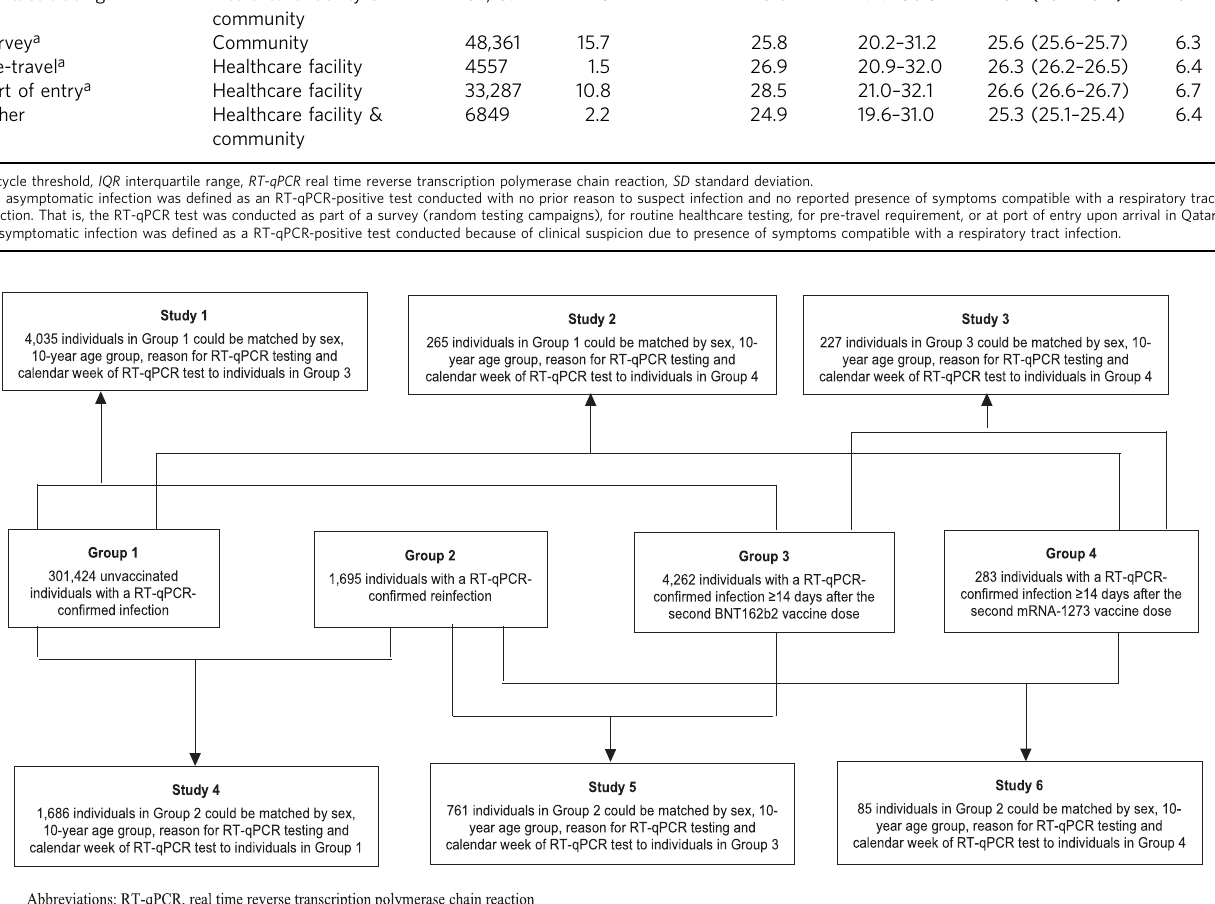
Fig. 2 Schematic diagram showing the process of formulating the six pairwise comparisons between study cohorts. Schematic diagram showing the process of formulating the six pairwise comparisons between the cohorts of primary infections in unvaccinated individuals, reinfections in unvaccinated individuals, BNT162b2-vaccine breakthrough infections, and mRNA-1273-vaccine breakthrough infections, after 1:1 matching by sex, 10-year age group, reason for RT-qPCR testing, and calendar week of the RT-qPCR